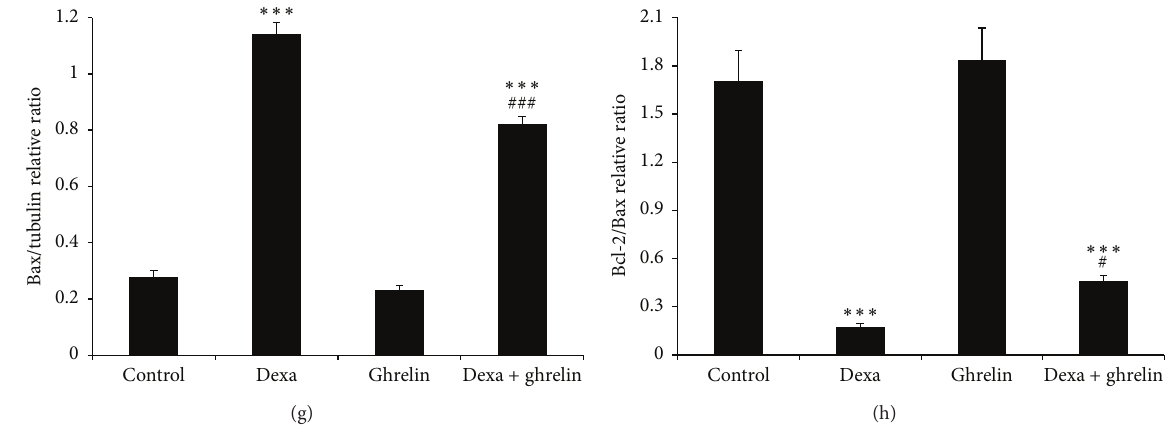
Figure 3: Ghrelin inhibits dexamethasone-induced mitochondrial-dependent apoptosis of INS-1 cells. (a) Extent of apoptosis following treatment with dexamethasone and ghrelin. INS-1 cells were cultured in complete medium (control), 0.1 𝜇 M dexamethasone, 0.1 𝜇 M ghrelin, and 0.1 𝜇 M dexamethasone + 0.1 𝜇 M ghrelin for 48h. INS-1 cells were then stained with PI and annexin V-FITC and sorted by fluorescence flow cytometry. (b) The graph presents the percentage of apoptotic INS-1 cells. (c) Ghrelin suppressed the activation of caspase-3 in